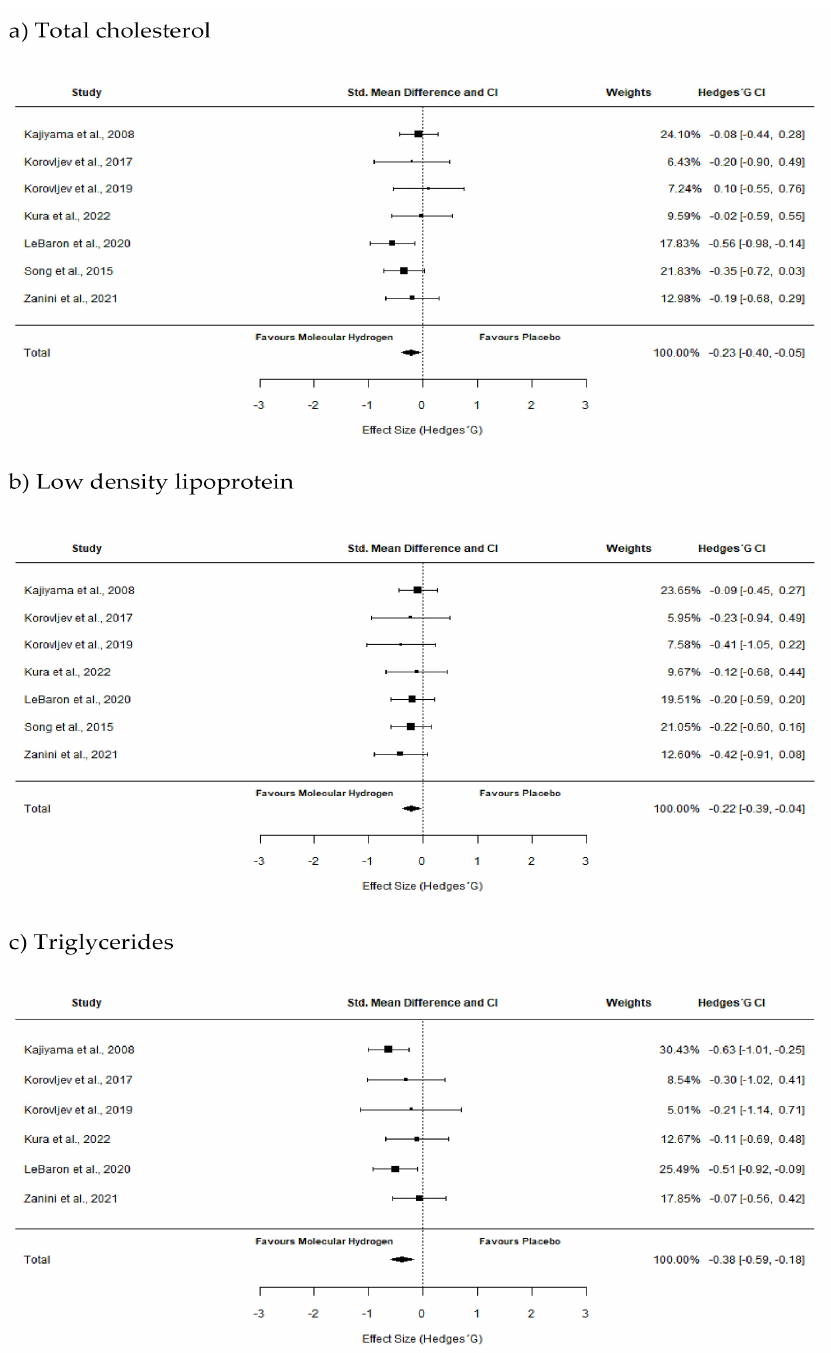
HRW supplementation lowers LDL levels ( p = 0.02) with small effect (pooled SMD = − 0.22 (from − 0.39 to 0.04)). Forest plots are shown in Figure 4.